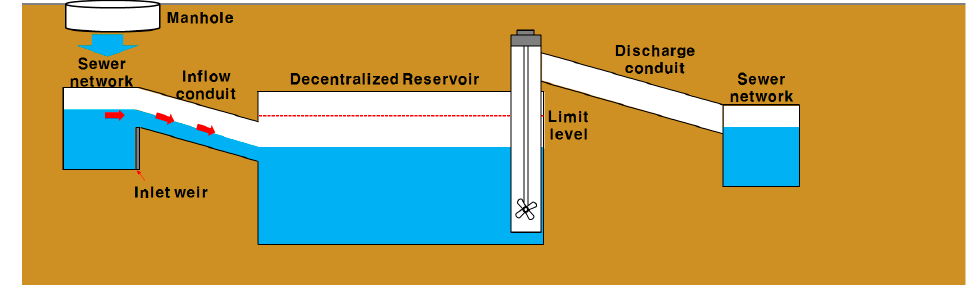
Figure 4. Structure of a typical decentralized reservoir.